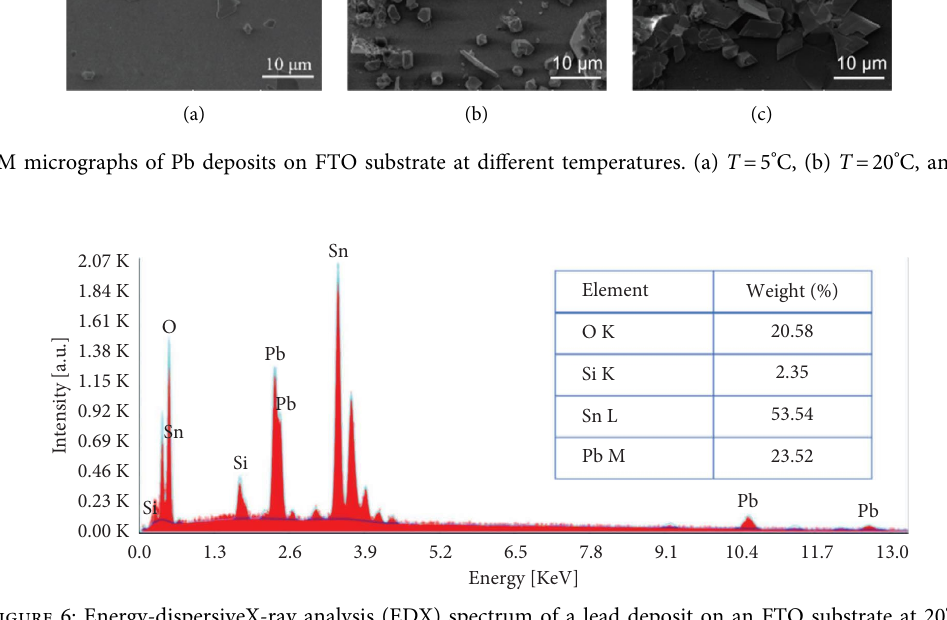
Figure 6: Energy-dispersiveX-ray analysis (EDX) spectrum of a lead deposit on an FTO substrate at 20 ° C.